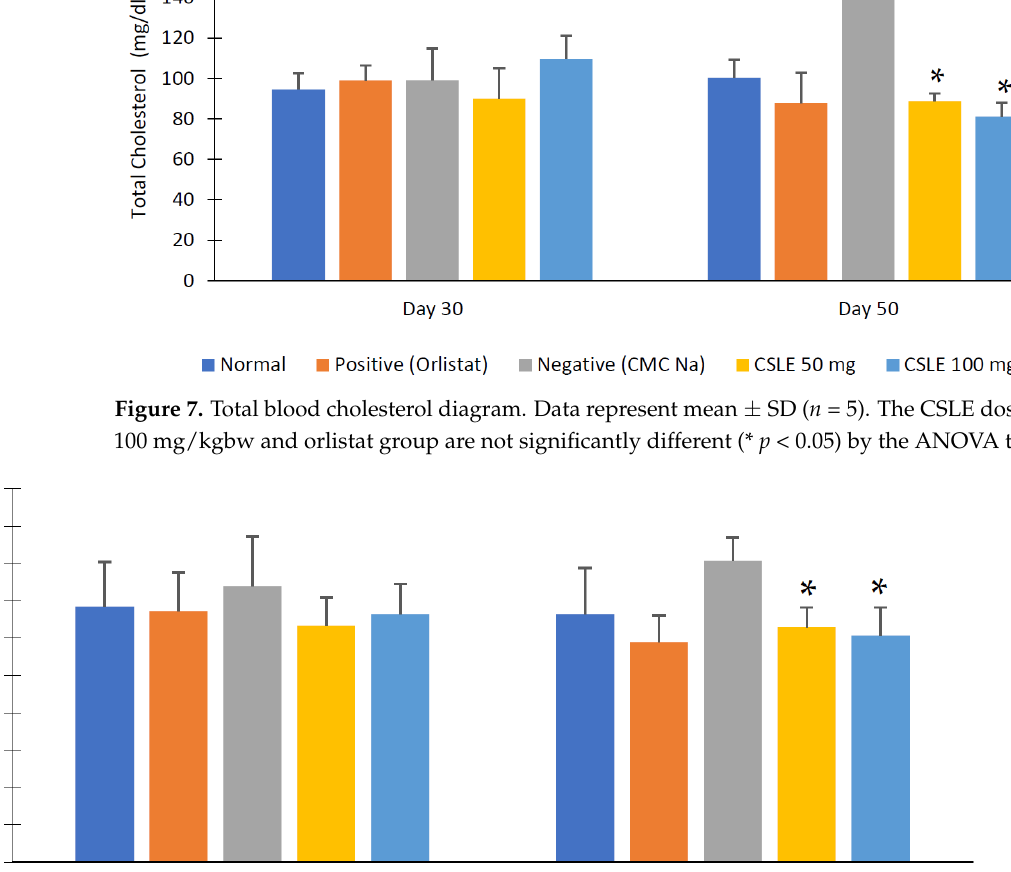
(day 30) compared to the last day as can be shown in Figure 7 and Figure 8, respectively.